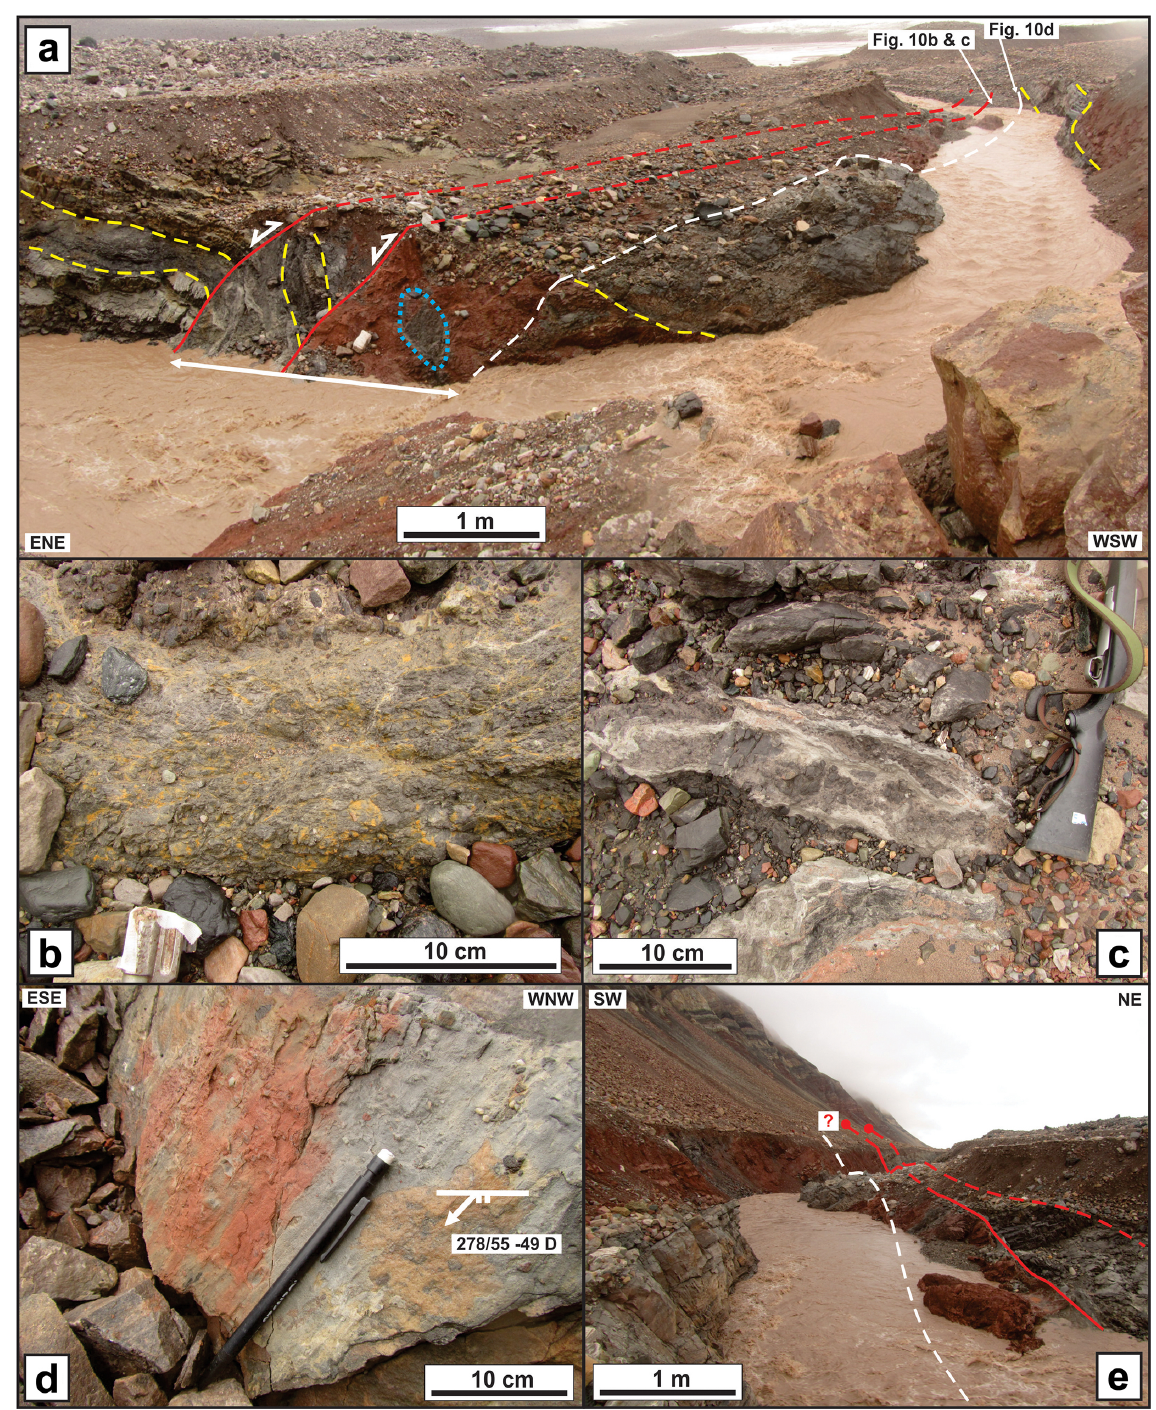
Figure 10. Eastward view of the Overgangshytta fault in the southern portion of the study area. Figure locations in Fig. 4. Panels (a) 2–3m wide core (subhorizontal white arrow shows the width of the core) of the Overgangshytta fault (red) incorporating meter-size lenses of host rock (dotted blue). Note the potential meter-scale reverse offset, possibly drag fold in the hanging wall, and highly tilted (bedding in dashed yellow) character of coaly shales and grey sandstones of the Billefjorden Group across the fault. (b) Decimeter-scale light-colored and (c) ap- proximately 10cm wide yellowish lenses of fault gouge within the Overgangshytta fault core. (d) Slicken grooves and asperities indicating normal dip-slip movement within the Overgangshytta fault core. See Fig. 10a for location. (e) Northwestward view of the Overgangshytta fault and adjacent cliff outcrops made of sedimentary rocks of the Hultberget, Ebbadalen, and Minkinfjellet formations suggesting that the fault dies out vertically and/or laterally. The fault core is limited by the dashed white and dashed red lines and is approximately 3m wide. Solid Earth, 9, 1535–1558,